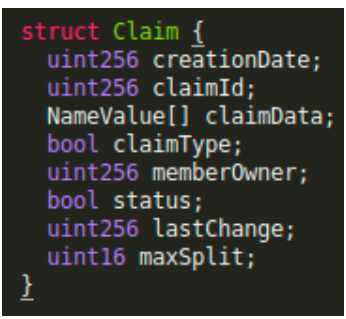
Figure 7. Solidity smart contract structure representing a claim.